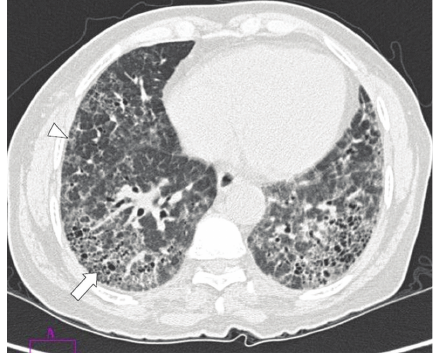
Figure 3: HRCT demonstrating interstitial thickening (arrow head) and honeycombing (arrow) in basal regions of